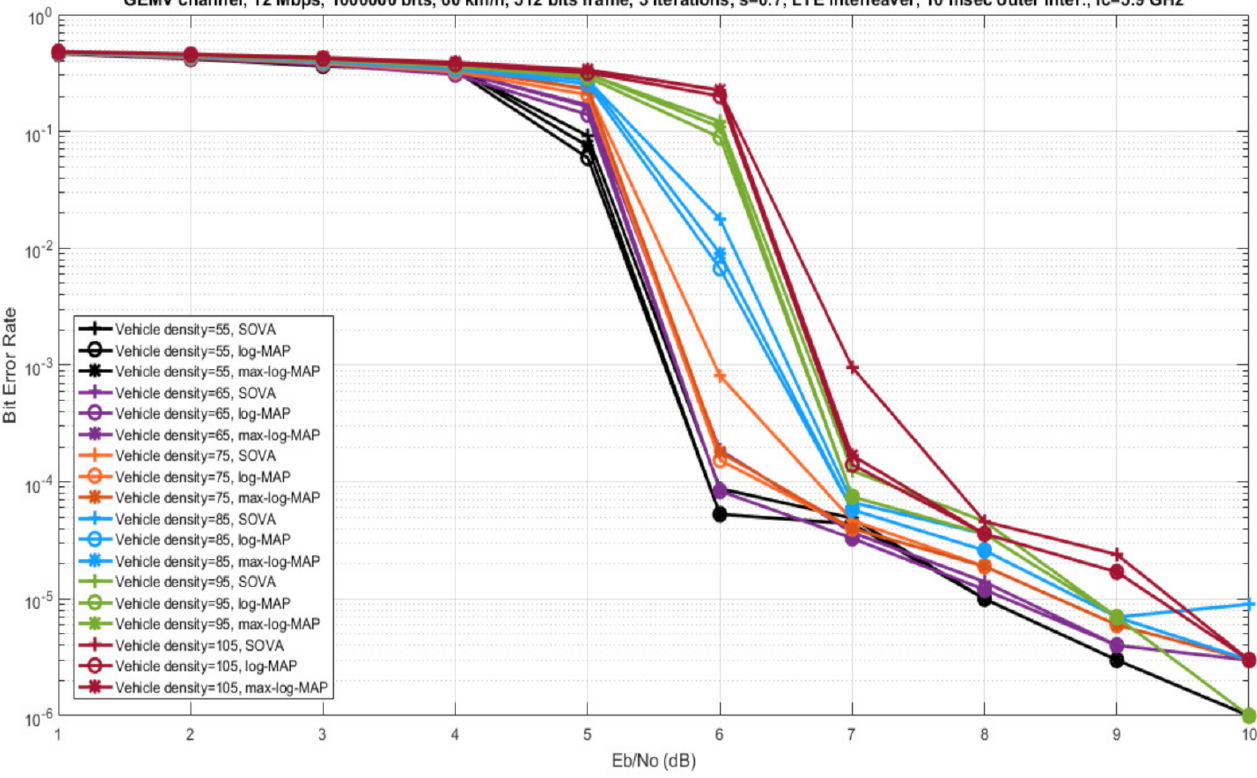
Figure 6. BER vs. SNR for GEMV channel, 6 different vehicle density values, 12 Mbps data rate, 60 km/h vehicle speed, different decoding algorithms, 3 iterations, frame length of 512